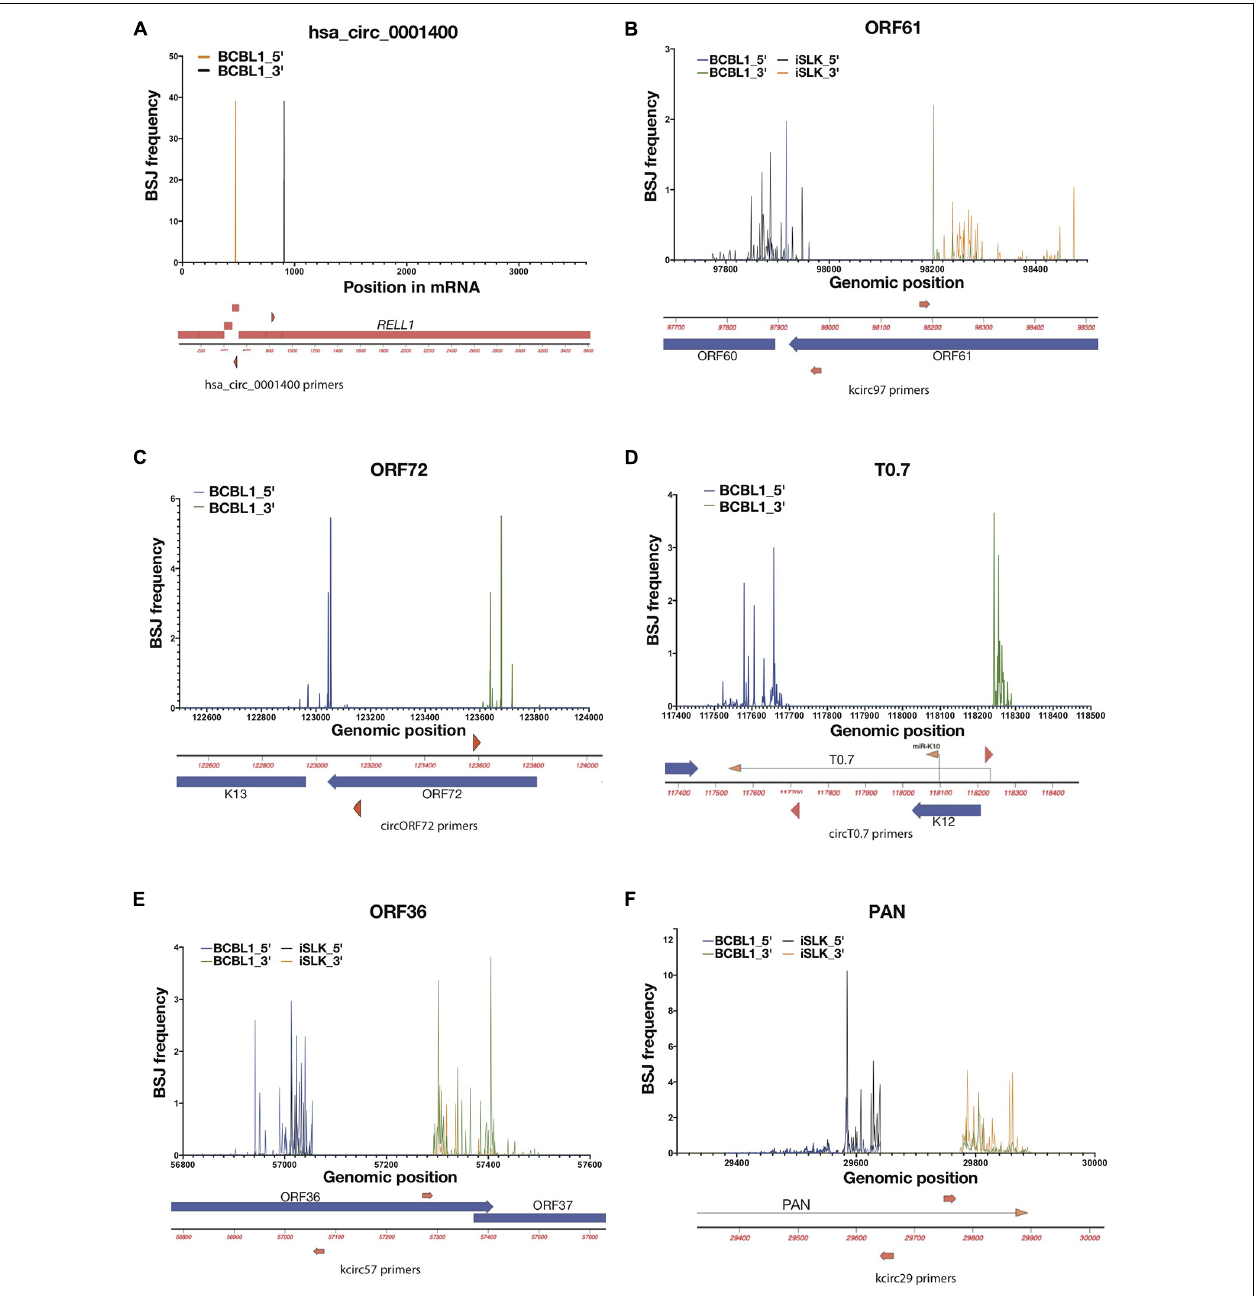
FIGURE 2 | Variabilities of back-splice junction (BSJ) loci in KSHV. Frequencies of 5 (cid:48) and 3 (cid:48) positions of back-spliced junctions detected in reactivated iSLK-BAC16 (iSLK) and TREx-BCBL1 RTA (BCBL1) cell lines. Total RNAs from KSHV-positive cell lines were RNase R-treated and RT-PCR was performed to amplify BSJ regions. Amplicons were sequenced and mapped to KSHV genome (NC_009333), and 5 (cid:48) and 3 (cid:48) BSJs are shown as percentages total detected viral BSJ reads (y-axis) for each divergent primer pairs (shown as red triangles or arrows, Supplementary Table 1 ) across flanking regions of circRNA-specific primers (x-axis). Human circRNA hsa_circ_0001400 serves as positive control of this analysis (A) . For viral circRNAs, genomic regions around ORF61 (B) , ORF72 (C) , T0.7 (D) , ORF36 (E) , and PAN (F) are shown with primer locations.